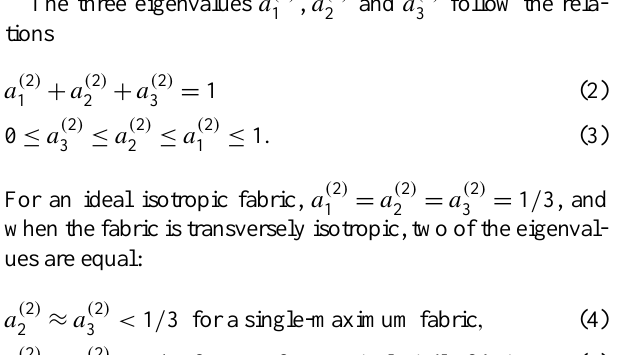
Figure 2. Top: fabric profile along the NEEM ice core, represented by the eigenvalues of the orientation tensor a ( 2 ) (dot: a ( 2 ) a ( 2 ) , plus: a ( 2 ) ). Error bars correspond to a ± 1 E r confidence inter- 2 3 val (see text). Bottom: evolution of the climate proxy isotope δ 18 O from the NGRIP ice core transferred to the NEEM depth scale (Ras- mussen et al., 2013) for the upper 2200m, and from the NEEM ice core below 2200m depth (dashed line) (Dahl-Jensen et al., 2013). The NEEM isotope data are not available yet, but the overall fea- tures are very similar to those of NGRIP. The arrow represents the depth of the glacial termination at NEEM,